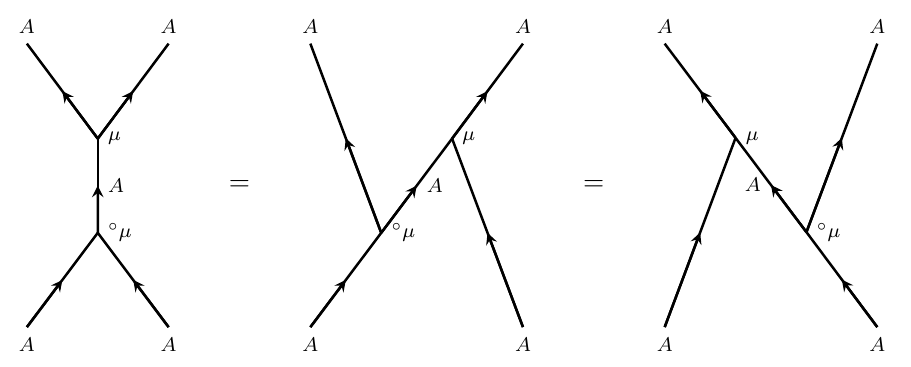
Figure 13 . Frobenius axiom for an algebra object A 2 C .